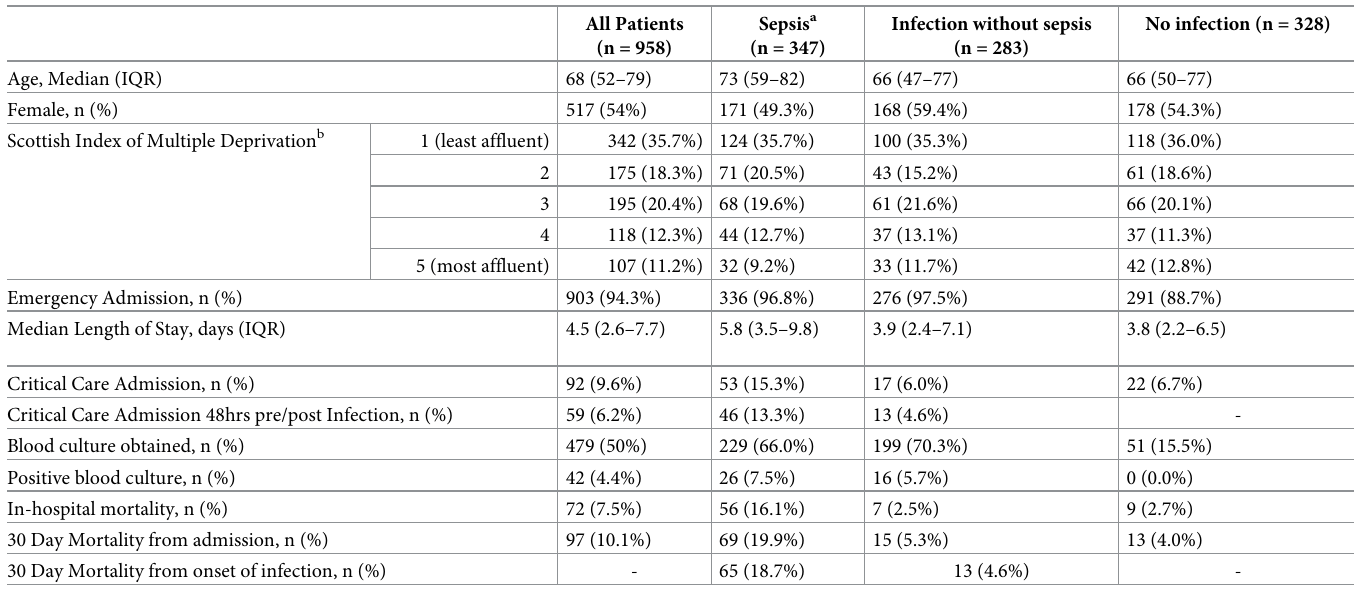
Table 2. Demographics and clinical characteristics.